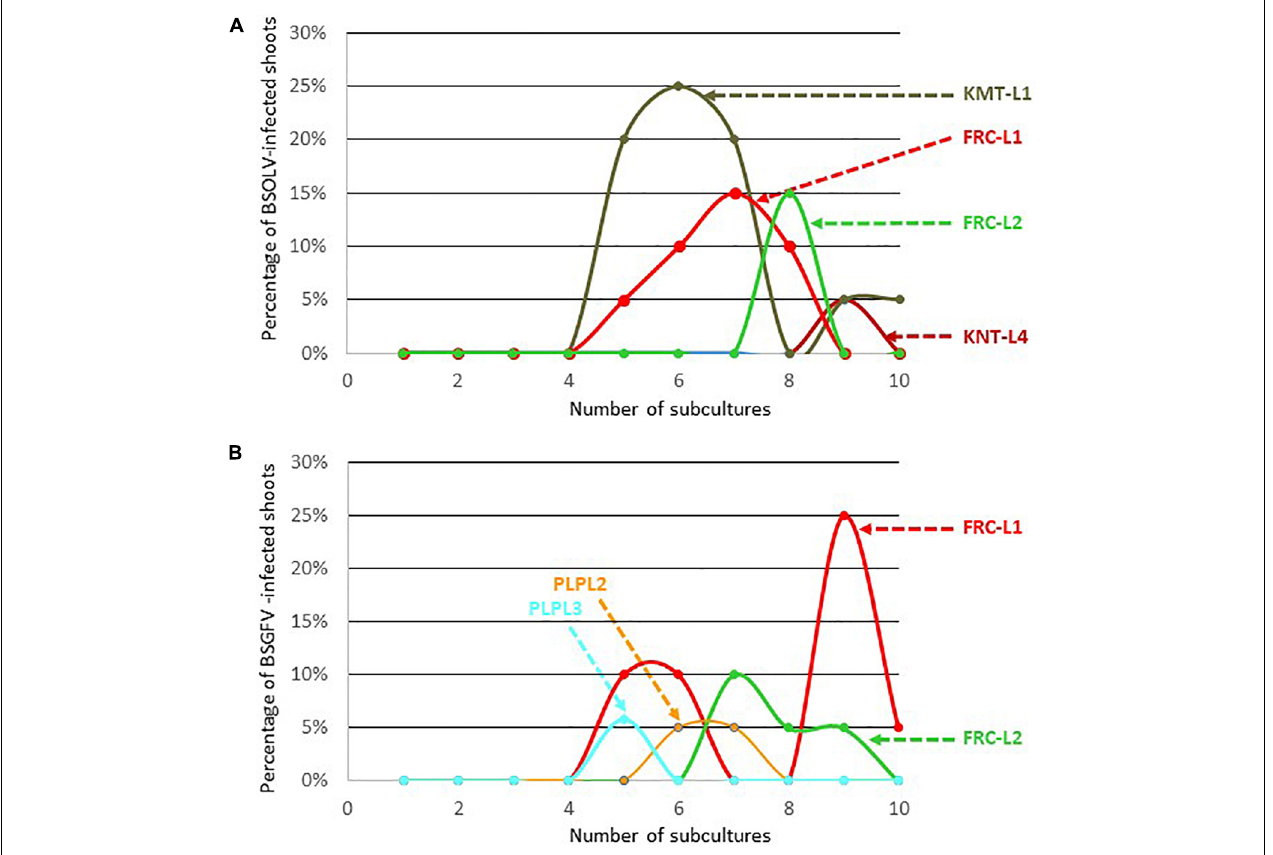
FIGURE 1 | Kinetics of activation of eBSOLV (A) and eBSGFV (B) infectious alleles in cultivars Kelong mekintu (KMT), French Clair (FRC), Kunnan tetraploid (KNT) and Pelipita (PLP) during cell